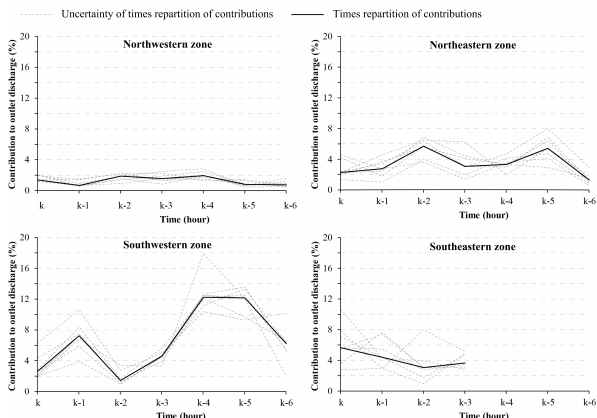
Figure 2. Median and total spread (%) of respectively northwest- ern, northeastern, southwestern and southeastern zone contributions versus